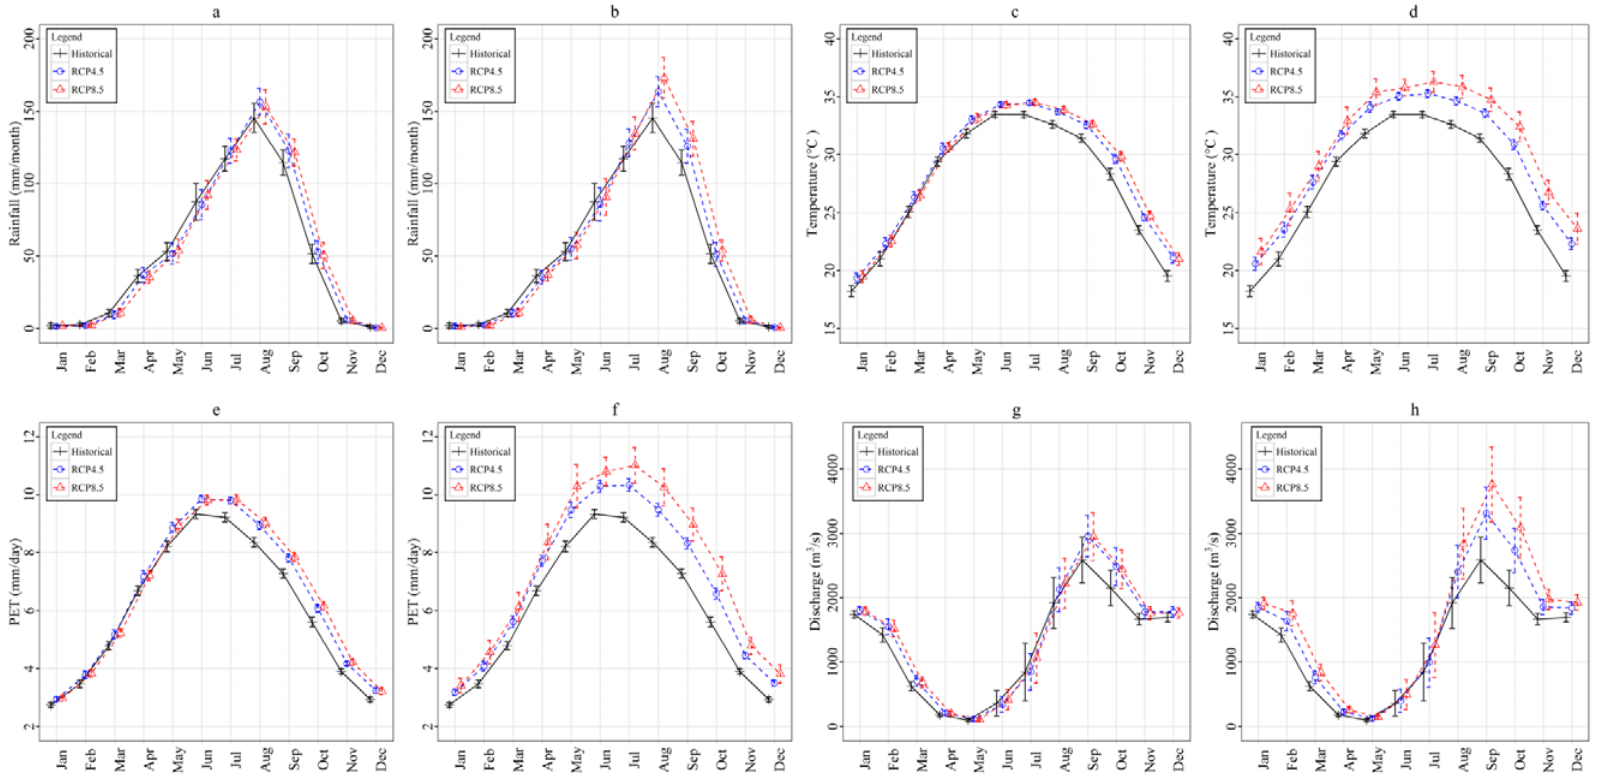
Figure 5. Ensemble mean projected monthly hydro-climatic projections from eight GCMs in the near (2010–2035) and far (2036–2099) future. ( a ) Near future rainfall; ( b ) far future rainfall; ( c ) near future temperature; ( d ) far future temperature; ( e ) near future PET; ( f ) far future PET; ( g ) near future discharge; ( h ) far future discharge: points indicates the within month means while error bars gives the within month standard deviations of the ensemble mean.